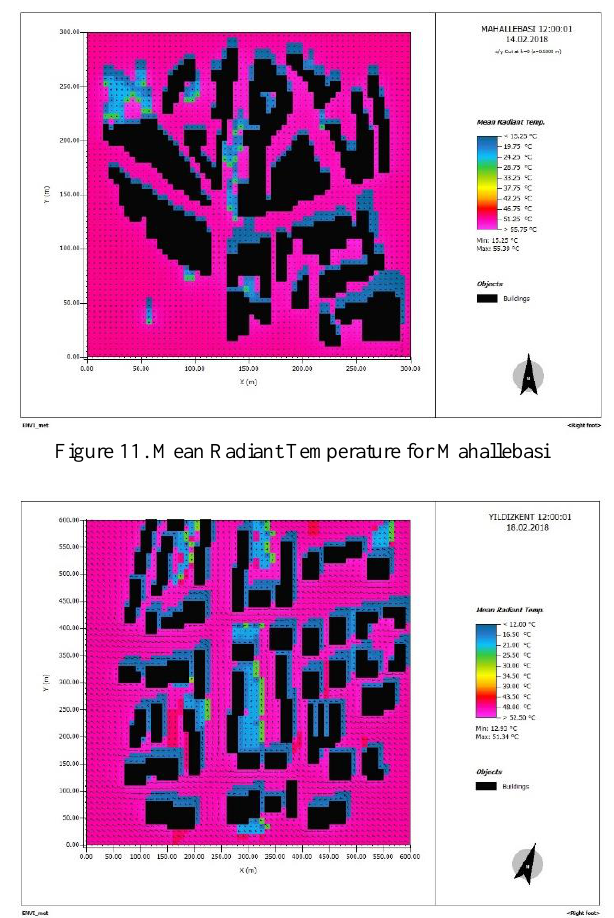
Figure 12. Mean Radiant Temperature for